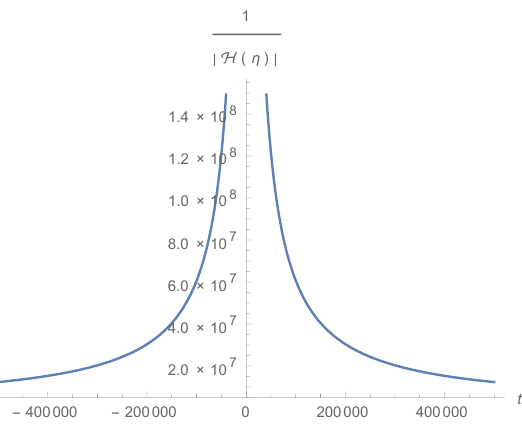
Figure 7. Time evolution of the comoving Hubble radius for the time-symmetric bouncing solution of Figure 3 in vacuum